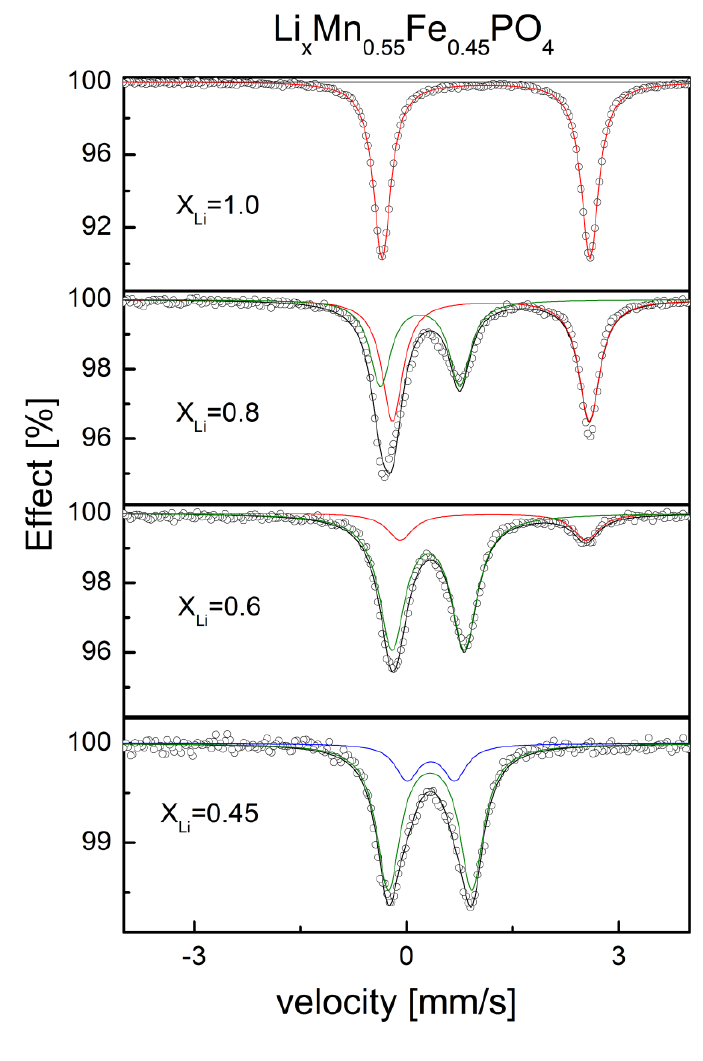
Figure 28. Moessbauer spectra for electrochemically deintercalated Li phosphoolivines with varying lithium concentration. Data from